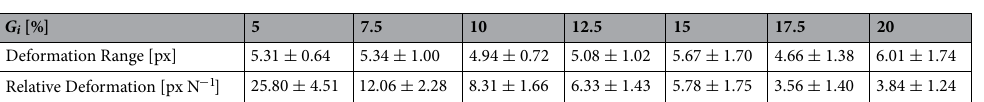
Table 1. Experimental Data: Range of minimal and maximum mean surface deformation in px during palpation experiments and deformation relative to the ground truth force given for all experiments performed for each gelatin